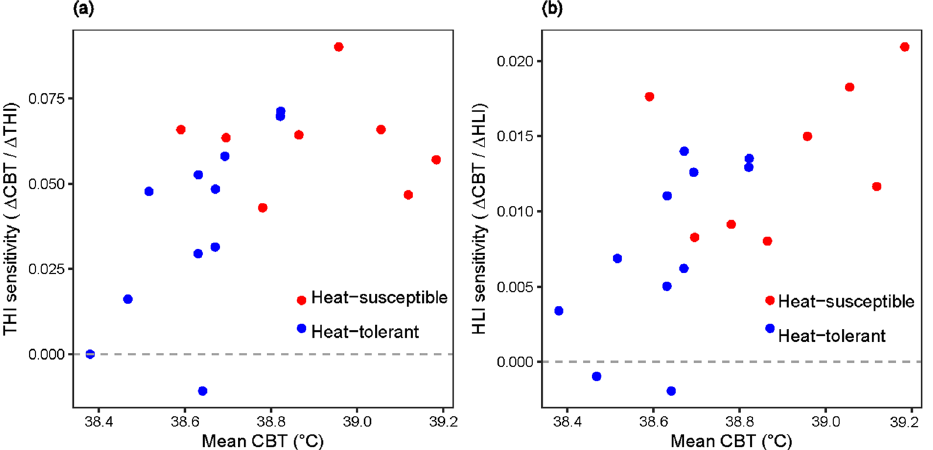
Figure 4. Sensitivity of core body temperature (CBT) change on THI and HLI deviations. Slopes of the individual animal CBT response curves across THI and HLI deviations were plotted against the average recorded CBT of each